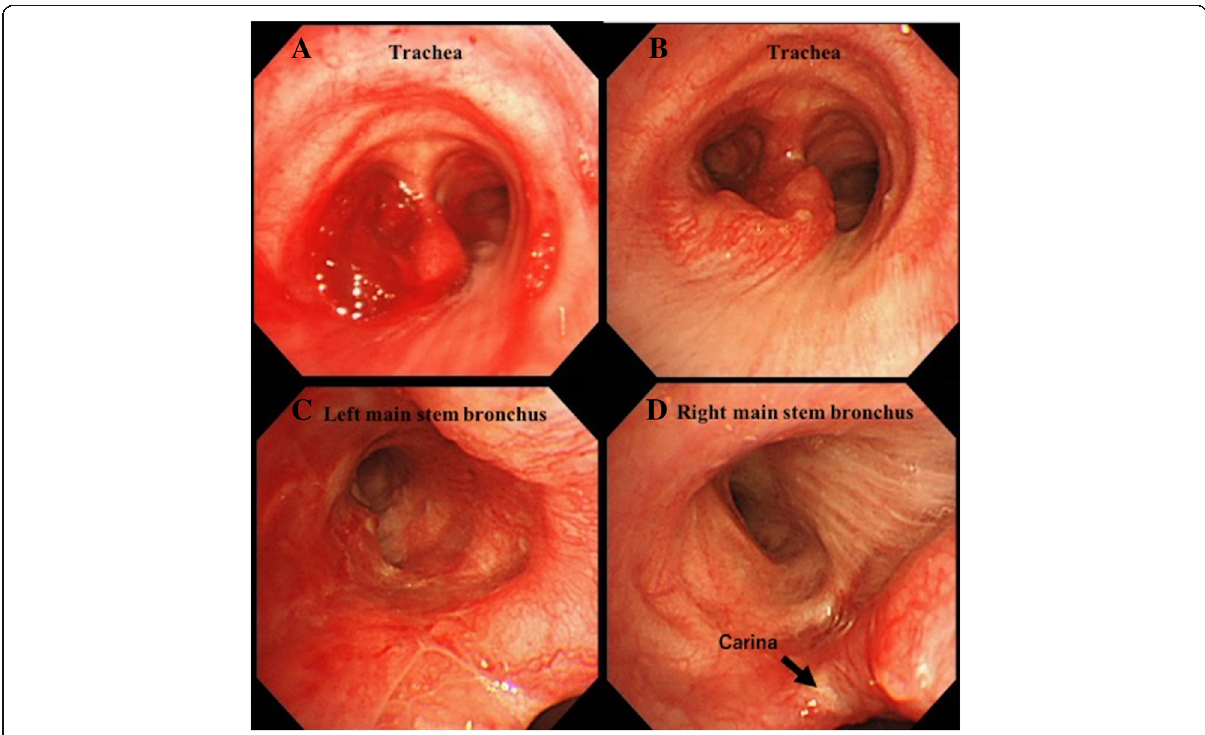
Fig. 2 Endoscopic findings. a Before rigid bronchoscopic treatment. The tumor almost completely occludes the left main stem bronchus. b , c , and d Bronchoscopy 2 weeks after rigid bronchoscopic treatment. Almost the entire left main stem bronchus, two tracheal cartilage rings above the carina, and one right main stem bronchial ring distal from the carina are invaded by the